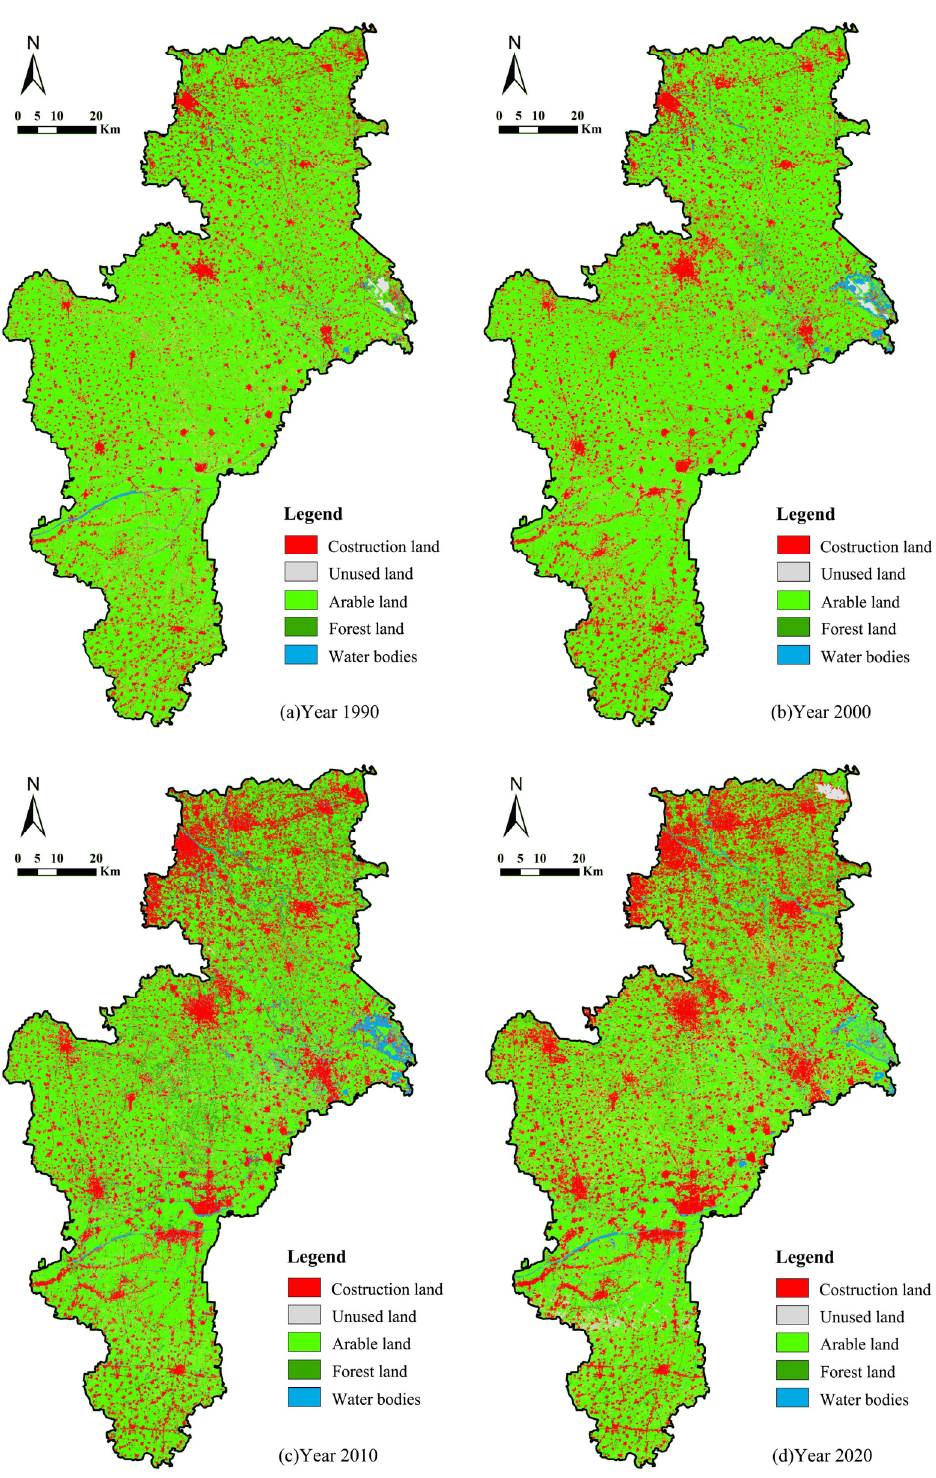
Figure 3. Spatial distribution of land use in the TWL region in ( a ) 1990, ( b ) 2000, ( c ) 2010, and ( d ) 2020 (Source: